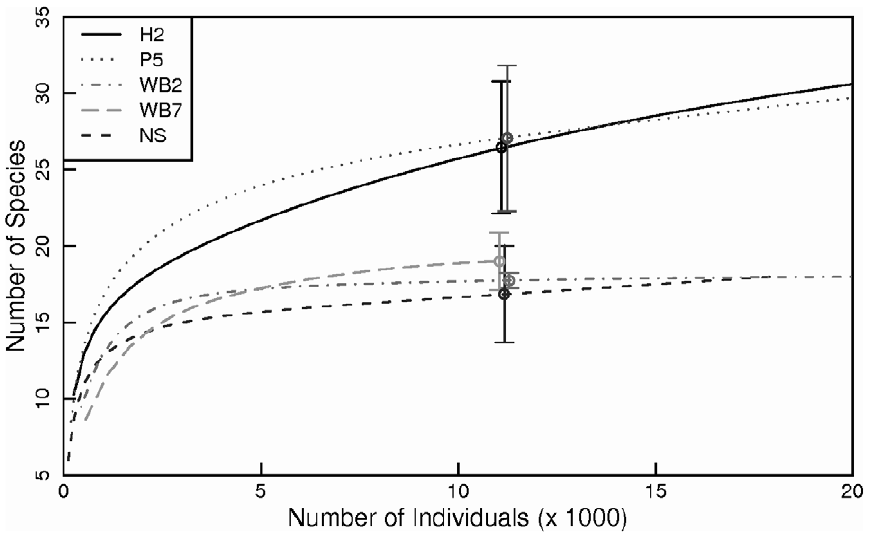
Figure 5. Species accumulation curves for adult copepods at time series stations in the Gulf of Maine. H2 – Halifax Line station 2; NS – New Scantum; P5 – Prince-5; WB2 and WB7; Wilkinson Basin Line stations 2 and 7, respectively. 95% confidence intervals were estimated for each station at the highest common number of individuals, N=11,168.